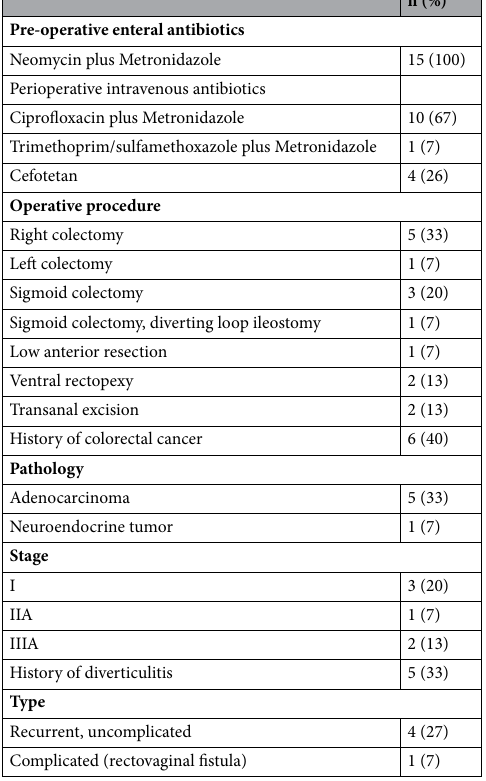
Table 2. Perioperative details and clinical history of surgery patients.